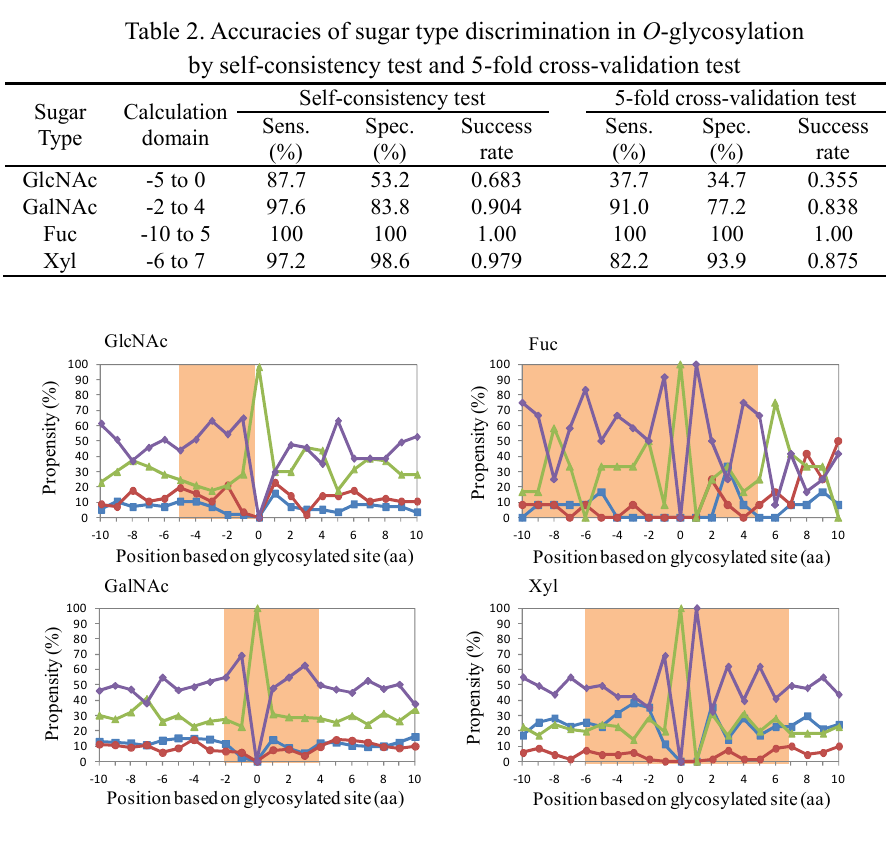
Fig. 2. Position-specific amino acid propensities around O -glycosylated sites. Red circles ( ● ) and blue squares ( ■ ) indicate positively charged and negatively charged residues, respectively. Green triangles ( ▲ ) and purple rhombuses ( ◆ ) indicate polar and non-polar residues,